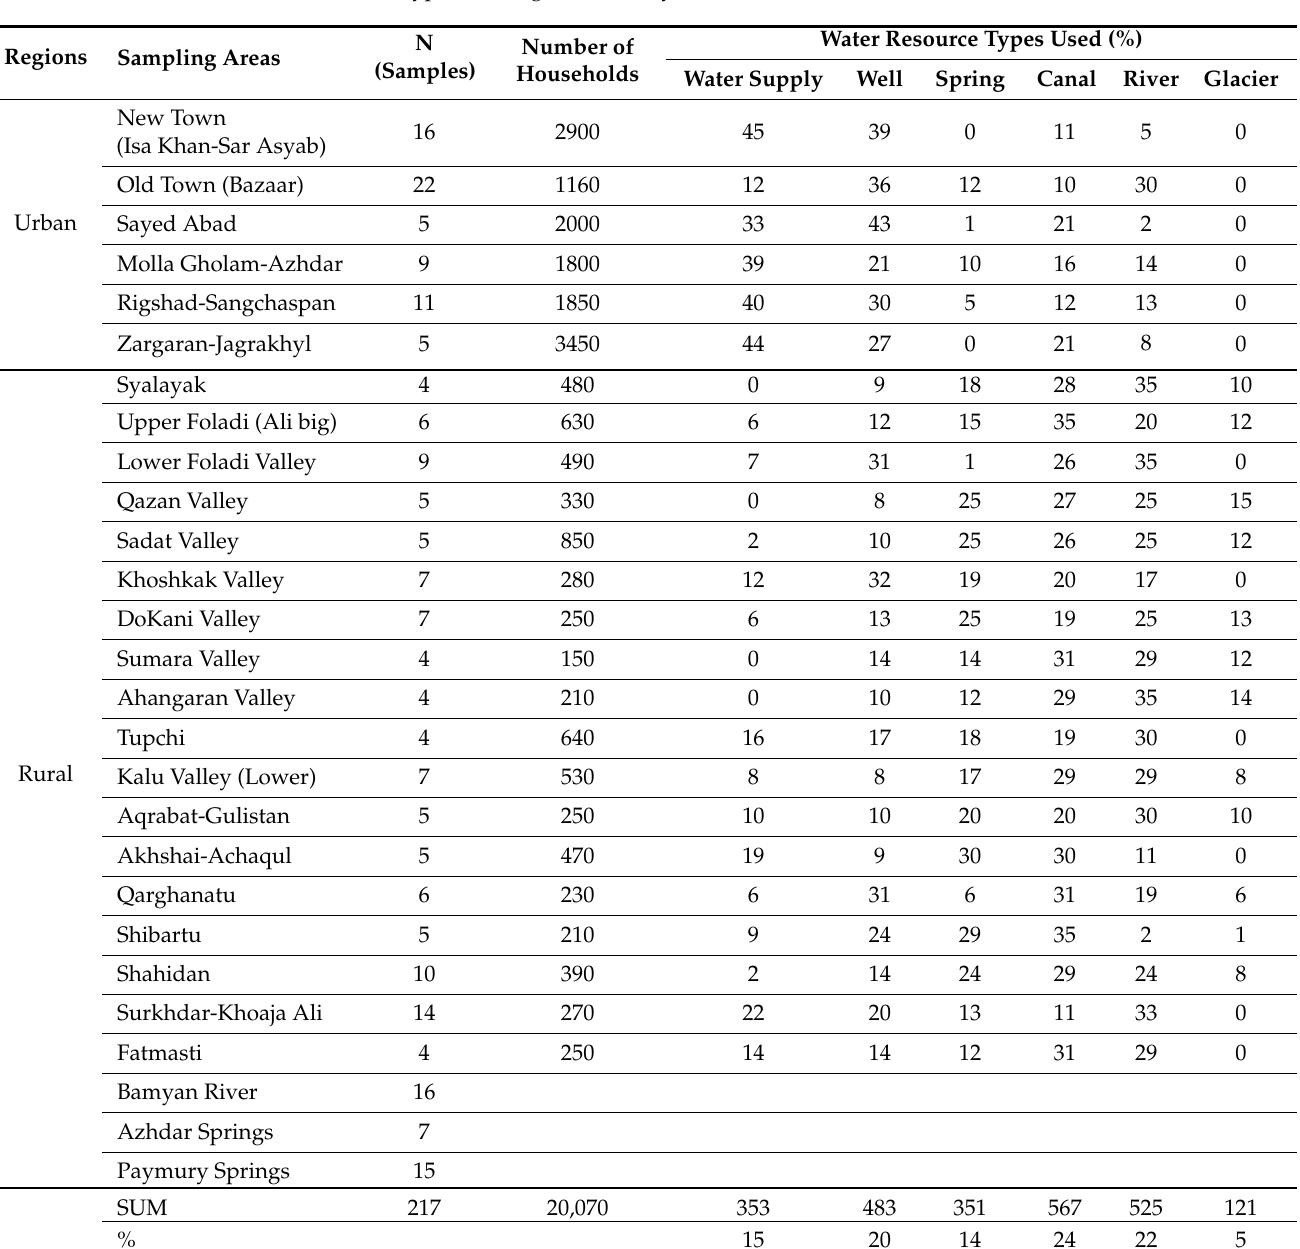
Table 1. Details of the location and number of samples collected/measured, and available water resource types investigated in Bamyan